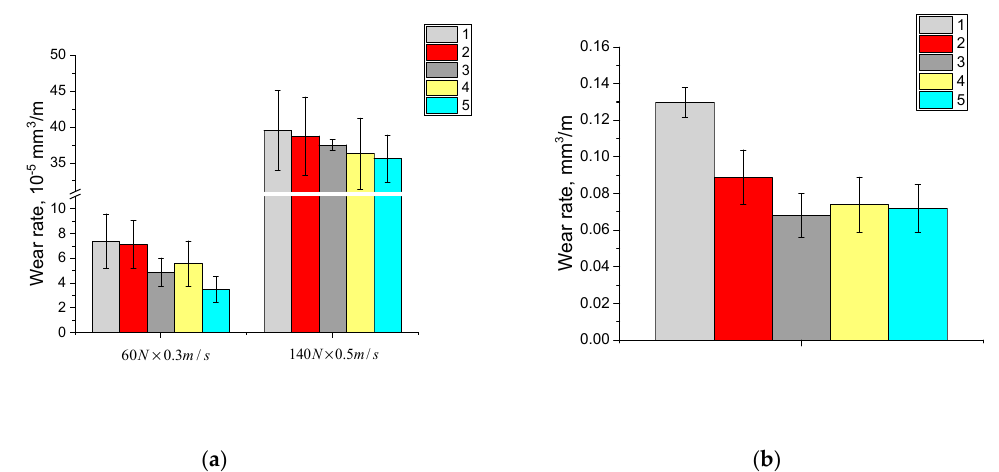
Figure 8. Diagrams on wear rates at dry sliding friction ( a ) and abrasive wear ( b ): 1—neat GUR 4120; 2—“GUR 4120 + 10% MGF annealed” composite; 3—“GUR 4120 + 10% MGF annealed and treated with “KH-550”” composite; 4—“GUR 4120 + 10% LGF annealed” composite; 5—“GUR 4120 + 10% LGF annealed and treated with “KH-550”” composite.